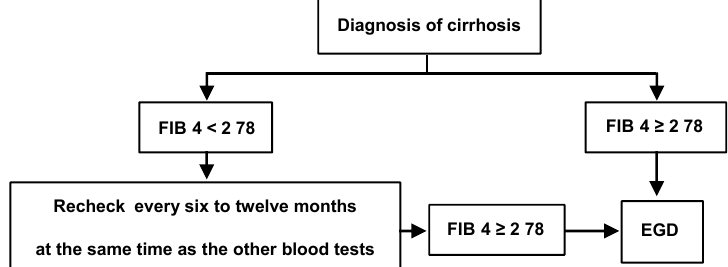
Figure 4. Algorithm for screening and follow-up of esophageal varices. The flowchart shows the algorithm for the management of esophageal varices using FIB-4. Patients with a FIB-4 of ≥ 2.78 should undergo screening with EGD. Determination of FIB-4 every 6–12 months concurrently with the other blood tests is recommended for those with a FIB-4 of < 2.78 until the FIB-4 reaches 2.78. EGD, esophagogastroduodenoscopy; EV, esophagealvarices; FIB-4, fibrosis index based on four factors.